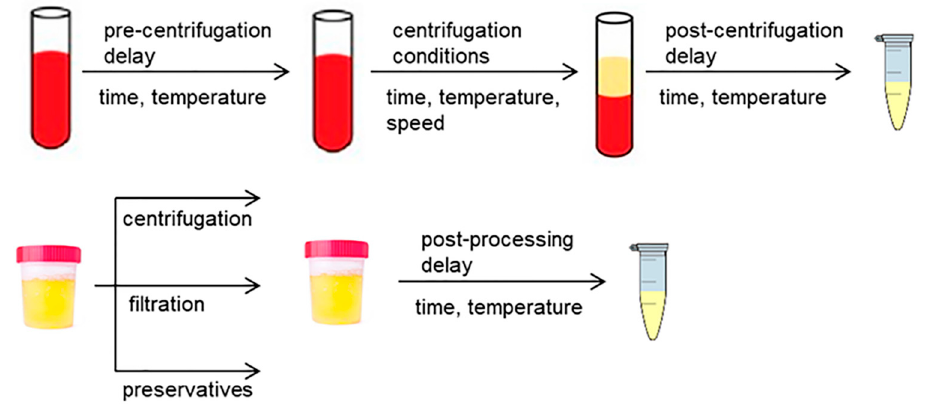
Figure 3. Summary of pre-processing factors influencing blood and urinary metabolomics.